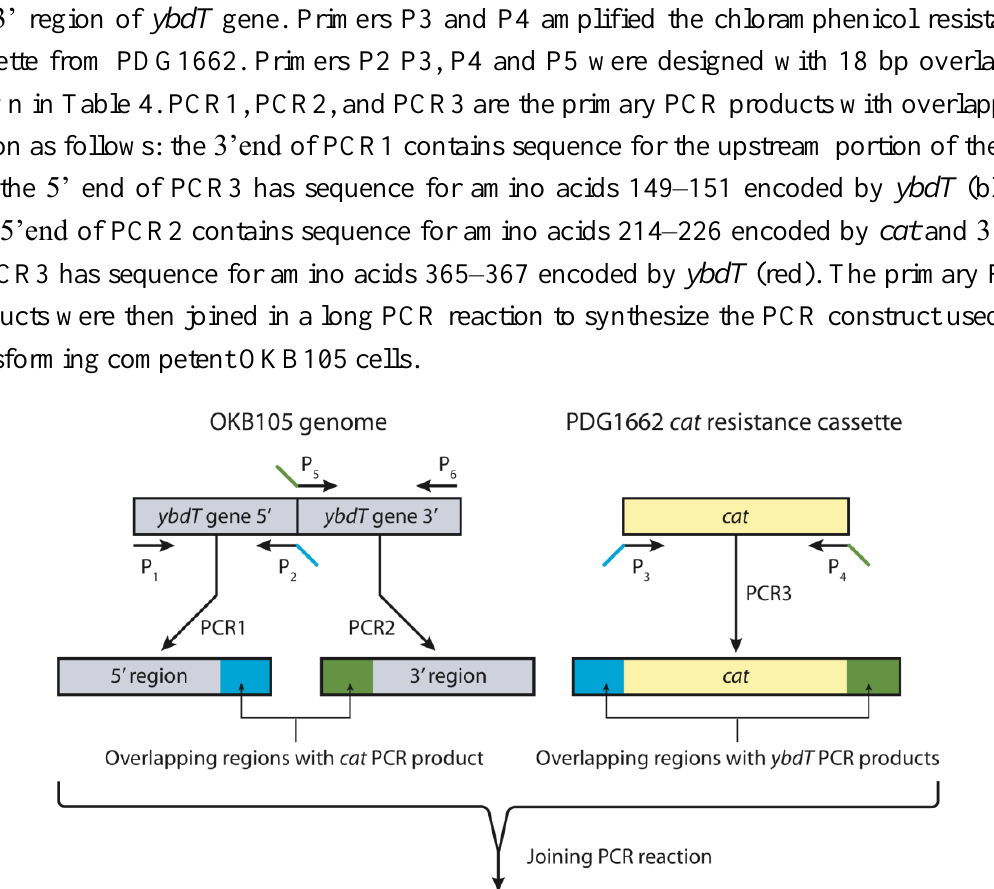
Figure 3. The overlap PCR protocol used to generate a ybdT mutation in OKB105. Primers P1 and P2 amplified the 5’ region of ybdT gene in OKB105. Primers P5 and P6